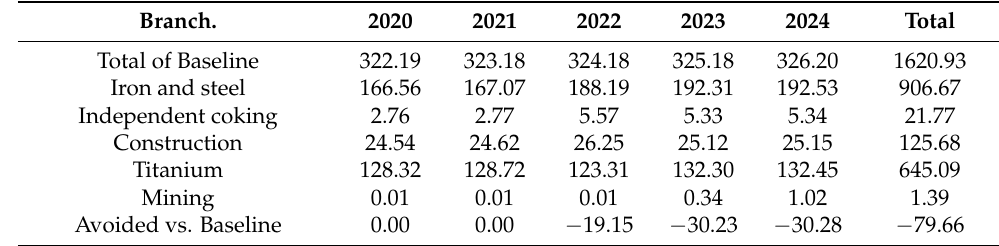
Figure 9. Indirect carbon emissions from key industrial modules under the pollutant treatment upgrade scenario and the difference plotted against the baseline scenario.